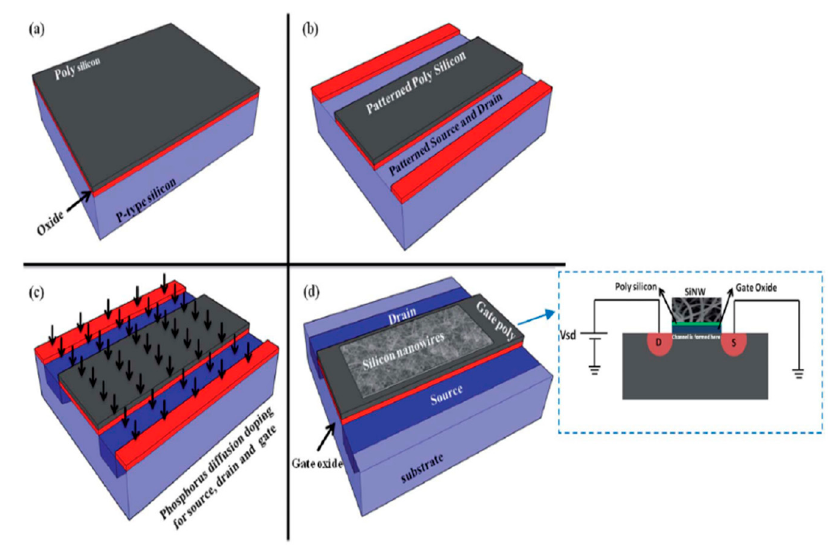
Figure 3. The schematic representation of the skein SiNW incorporated FET fabrication process. [82]. The image has been reproduced with permission from [82].